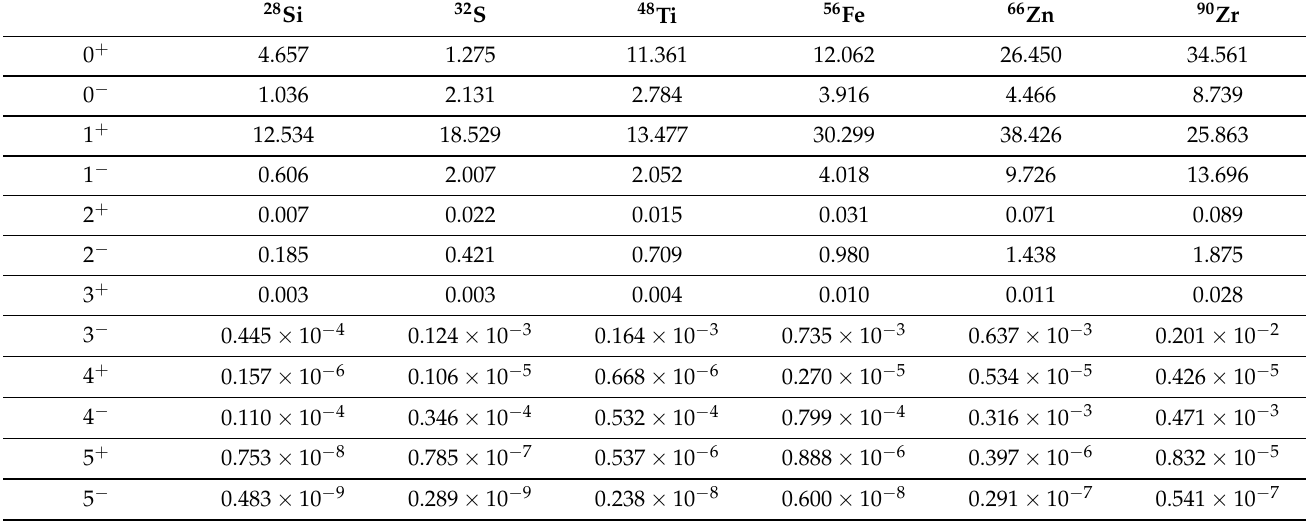
Table 1. Individual contribution σ e (in 10 − 42 cm 2 ) of low-spin multipolarities (up to J π = 5 ± ) to the total electron capture cross sections (at E e = 25 MeV), evaluated with the pn-QRPA method.